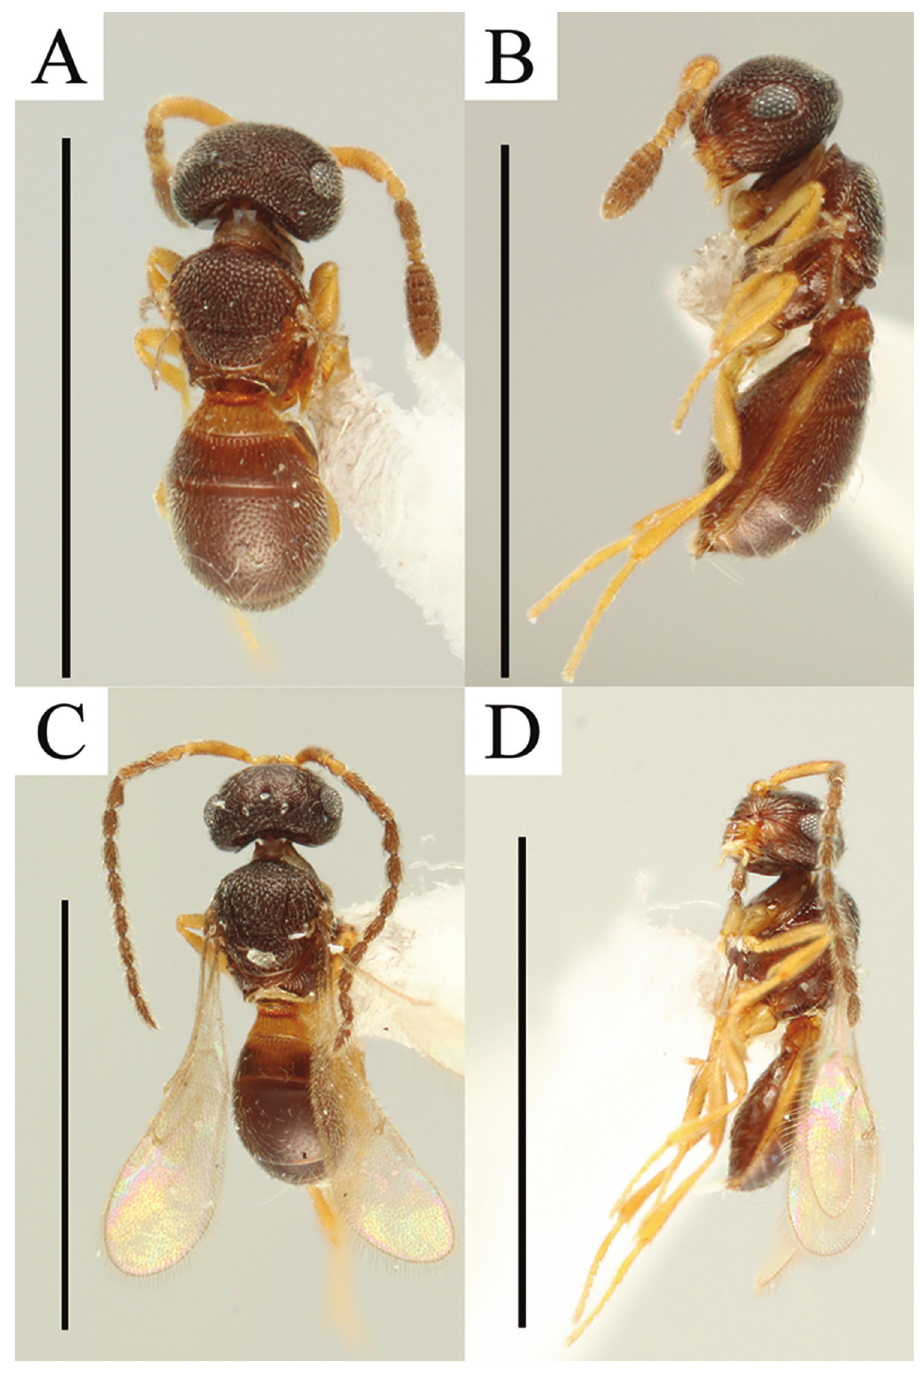
Figure 2. Trimorus granulatus sp. n. A female, dorsal view B female lateral view C male, dorsal view D male lateral view. Scale bars: 1